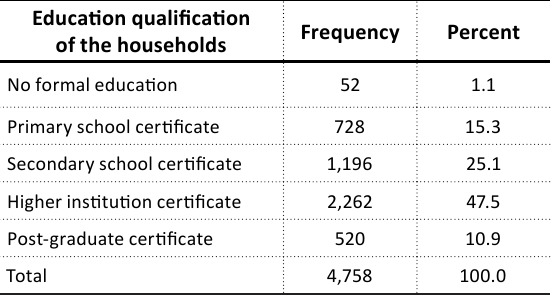
Table 7. Education qualification distribution